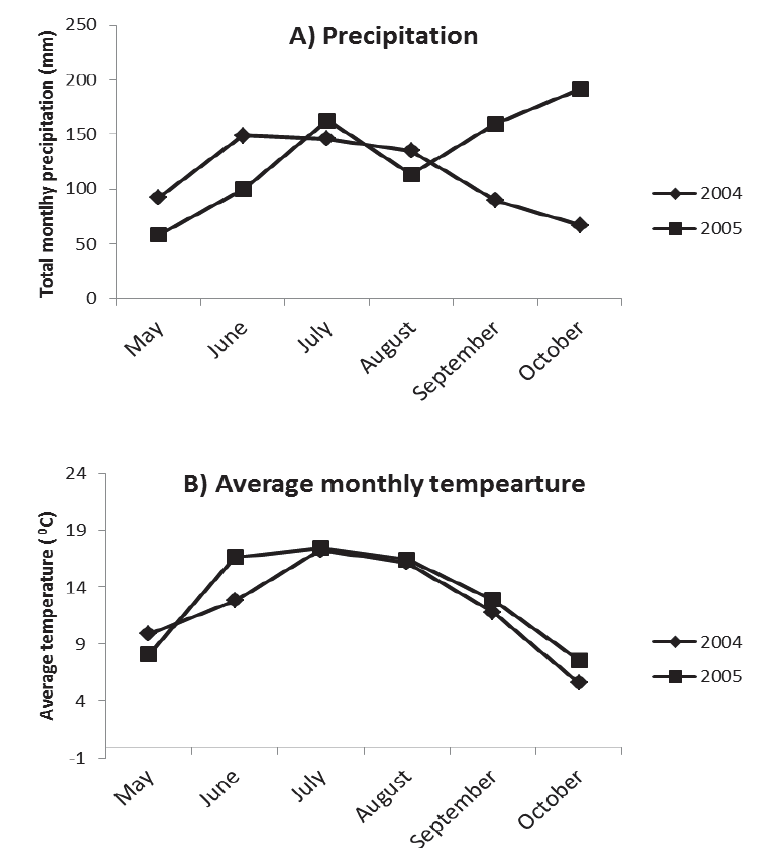
Figure 1. Monthly precipitation and average monthly temperature at studied